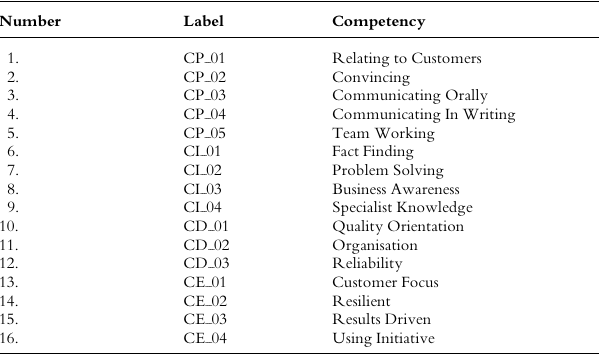
TABLE1 CUSTOMERCONTACTCOMPETENCY INVENTORY (CCCI) -COMPETENCIES